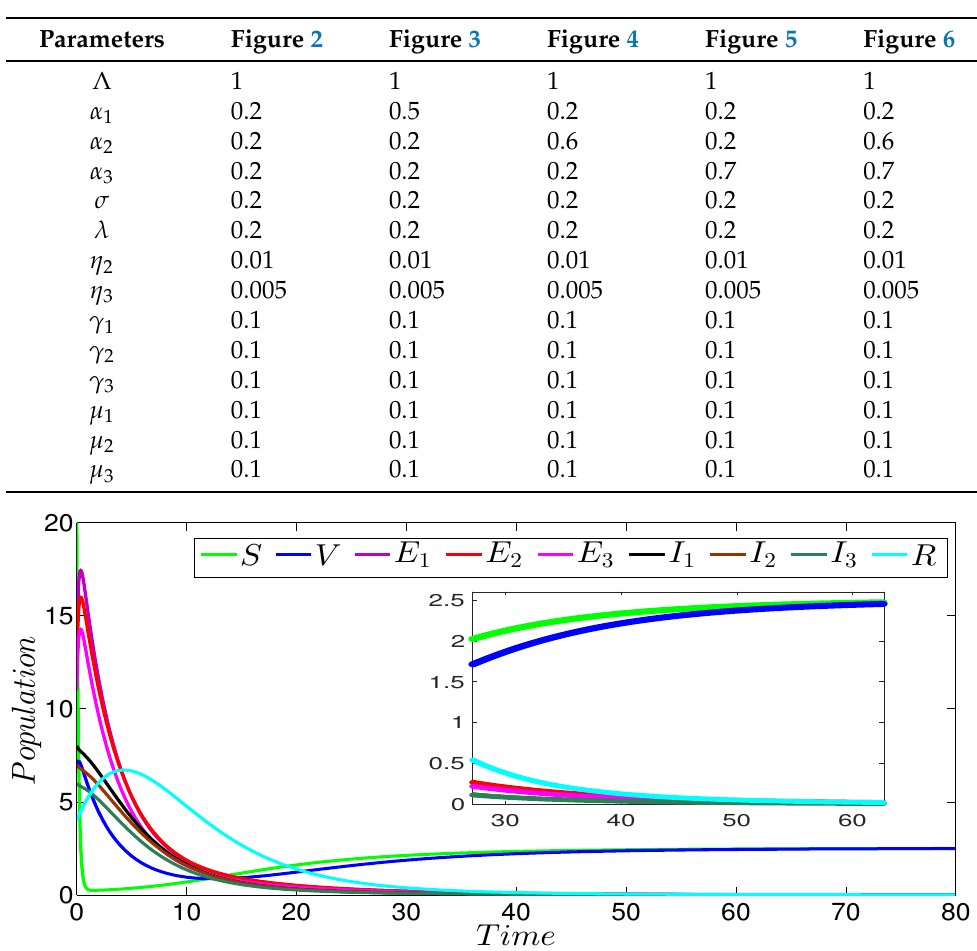
Figure 2. Stability of disease-free equilibrium E f of the three-strain SVEIR model with R 1 = 0.68. R 2 = 0.82, and R 3 0 0